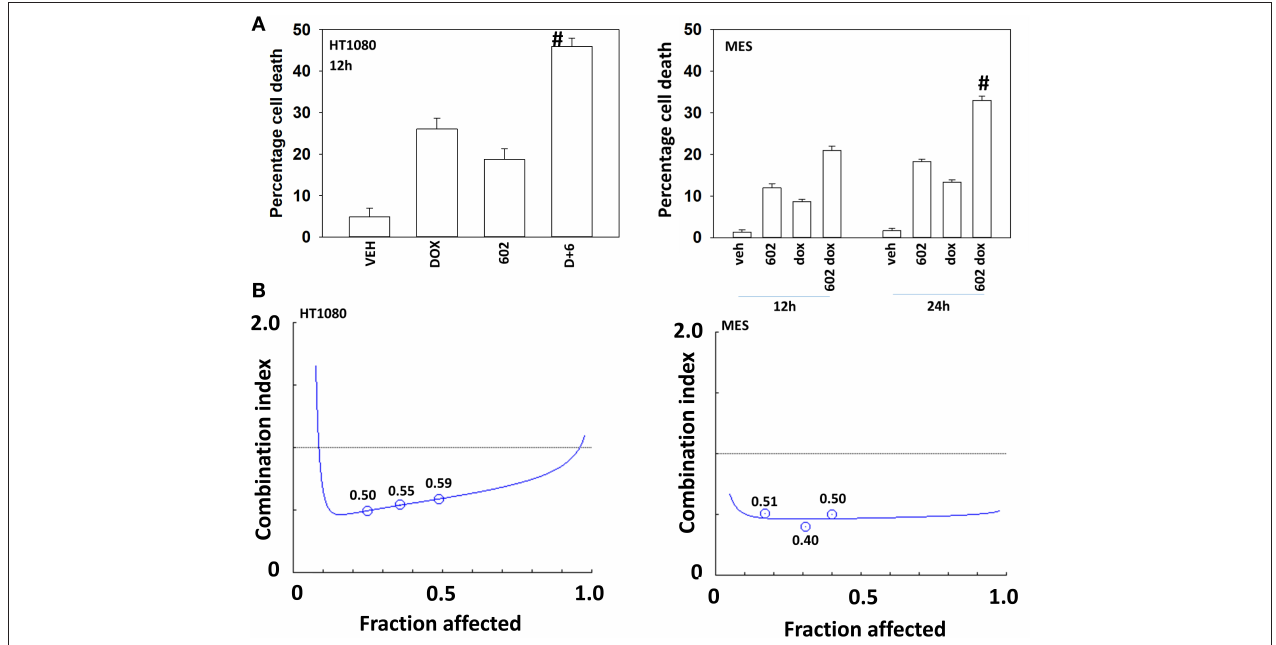
FIGURE 1 | GZ17-6.02 and doxorubicin interact to kill sarcoma cells. (A) HT1080 and MES human sarcoma cells were treated with vehicle control, GZ17-6.02 (2 µ M final curcumin), doxorubicin (200nM) or the drugs in combination for 12–24h. Cells were isolated, and viability determined by a trypan blue exclusion assay ( n = 3 + /–SD). # p < 0.05 greater than either 602 or doxorubicin alone. (B) Single cells were plated into 60mm dishes (500/dish, six separate dishes from two independent thawed cell vials). Twelve hour after plating cells were treated with vehicle control, 602 (0.5–2.0 µ M), doxorubicin (0.5–2.0 µ M) or the drugs in combination at a fixed dose ratio. Twenty-four hour after drug exposure, the growth media was removed, cells washed with drug free media and then cells were cultured for an additional 7 days in drug free media. Cells were fixed in place, stained with crystal violet and the number of colonies, a group of > 50 cells, counted. The synergy of drug interaction was determined via the Method of Cho and Tallalay using Calcusyn for Windows program. A combination index (CI) value of < 1.0 is considered